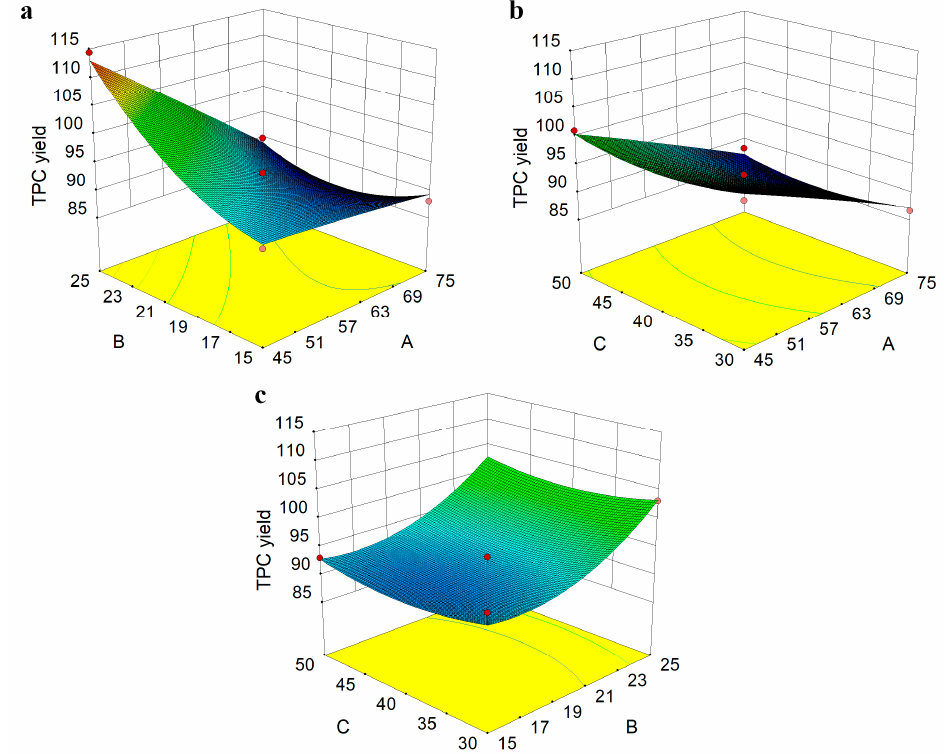
Figure 2. The three-dimensional response surface methodology of various factors on TPC in PE fruit, ethanol concentration and liquid-solid ratio ( a ), ethanol concentration and extraction temperature ( b ), liquid-solid ratio and extraction temperature ( c